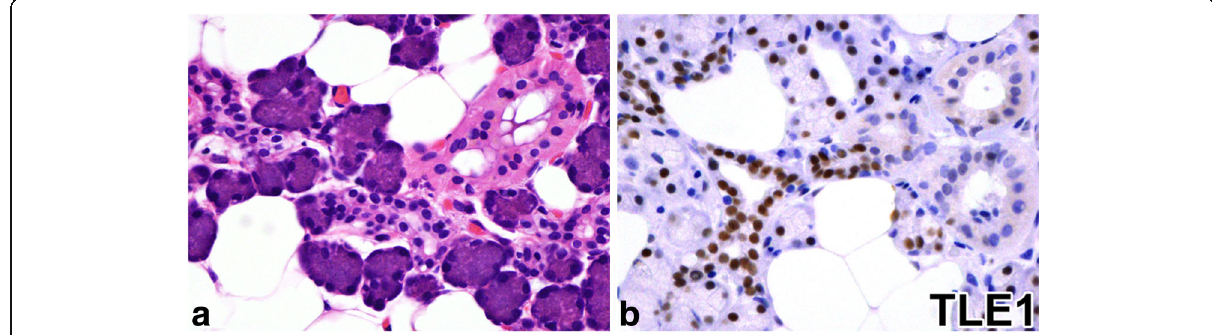
Fig. 1 Normal salivary glands ( a : hematoxylin – eosin staining, b : immunostaining for TLE1). Normal salivary gland forms ducto-acinar units composed of acini, intercalated ducts, striated ducts, and excretory ducts ( a ). Acinic cells and intercalated ductal cells are positive, and myoepithelial cells and excretory ductal cells are negative for TLE1 ( b